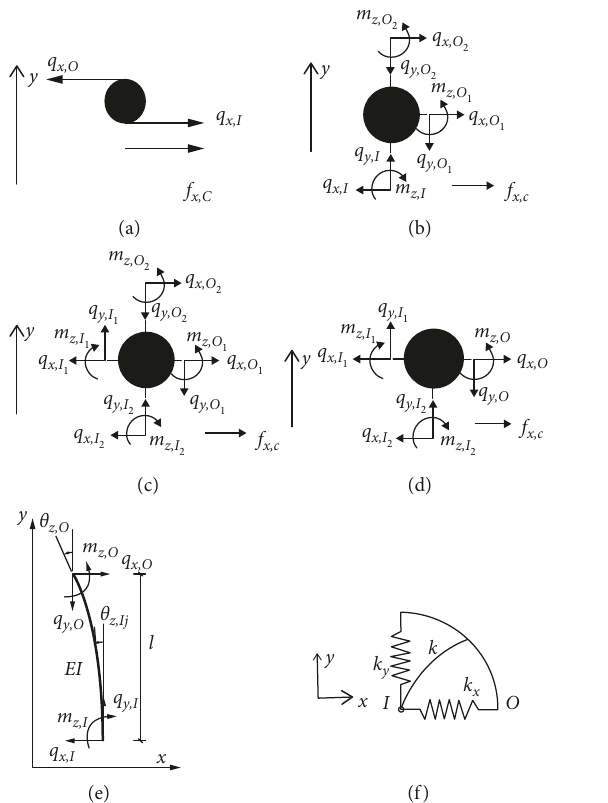
Figure 3: Elements schematic. (a) Concentrated mass at one input end and one output end, (b) concentrated mass at one input end and two output ends, (c) concentrated mass at two input ends and two output ends, (d) concentrated mass at two input ends and one output end, (e) the longitudinal elastic beam, and (f) planar elastic